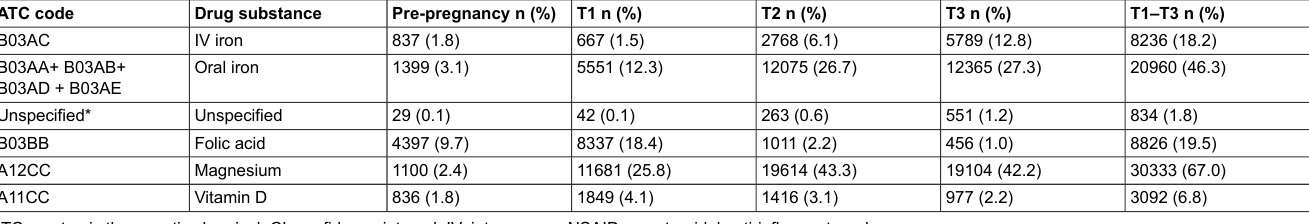
Table S4: Exposure prevalence to supplements (crude